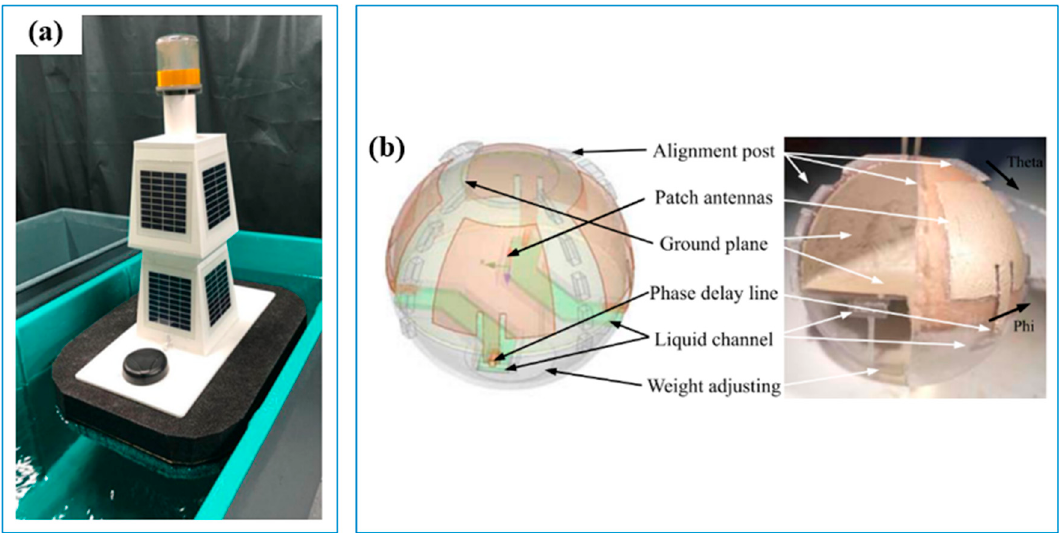
Figure 3. Three-dimensional-printed floating water quality measurement platform. ( a ) Floating water quality measurement system [48]. ( b ) Smart floating ball [15].